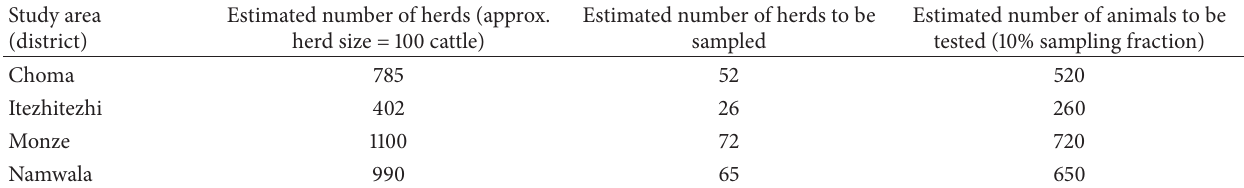
Table 2: Study areas with target herds and cattle sample